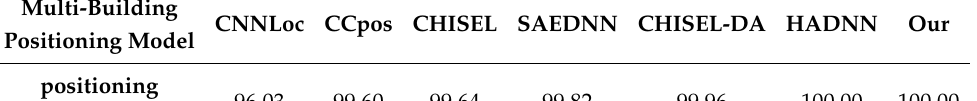
Table 4. Comparison of our algorithm and state-of-the-art deep learning methods for multi- building